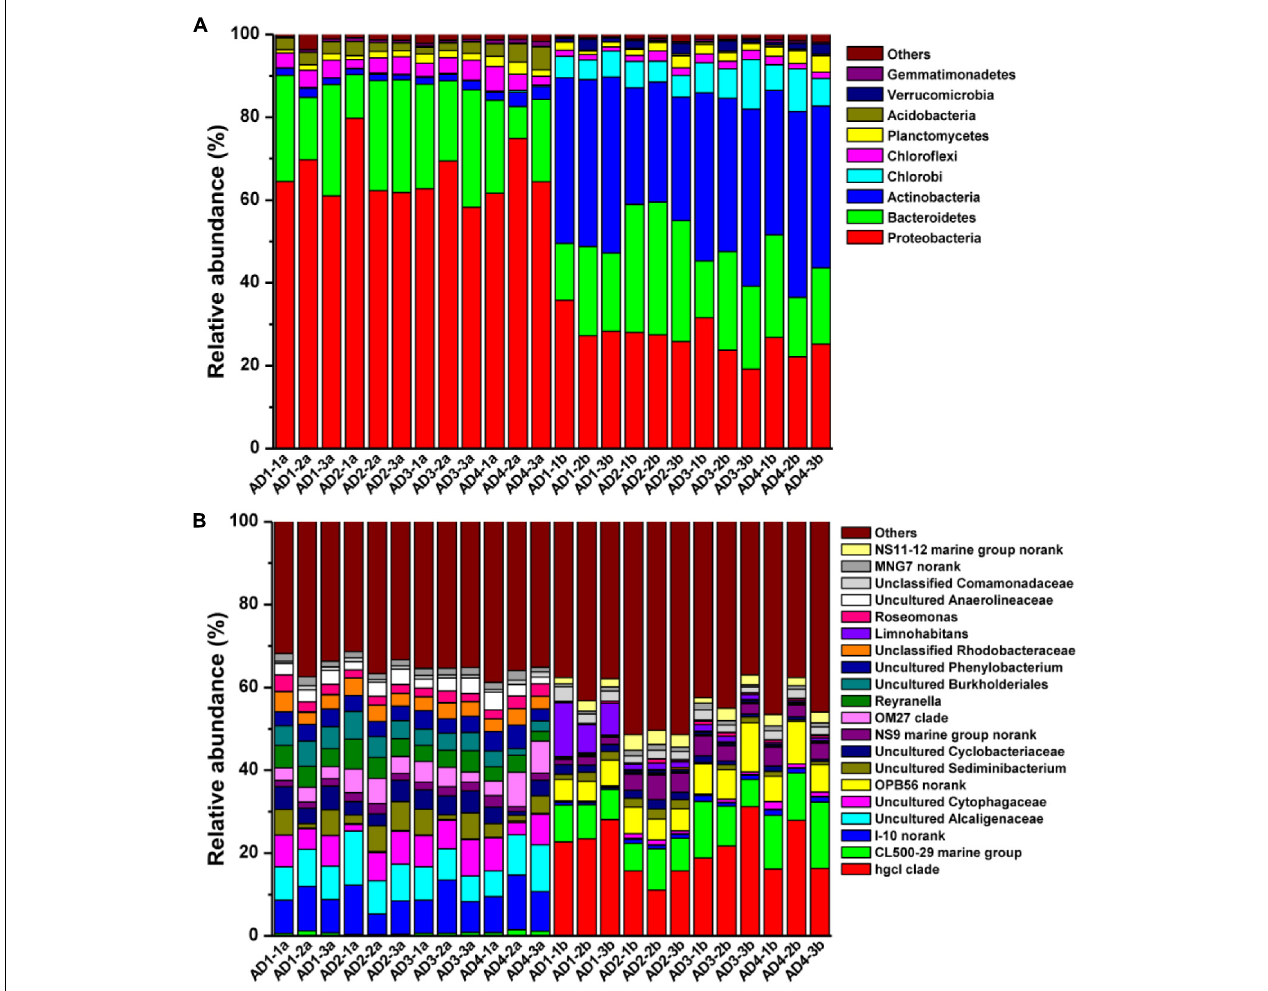
FIGURE 2 | Distribution of bacterial taxa at phylum (A) and genus (B) levels based on sequence data without cyanobacteria (Supplementary Table S2-resample 2). Sample names with a and b represent PAB and FLB, respectively.